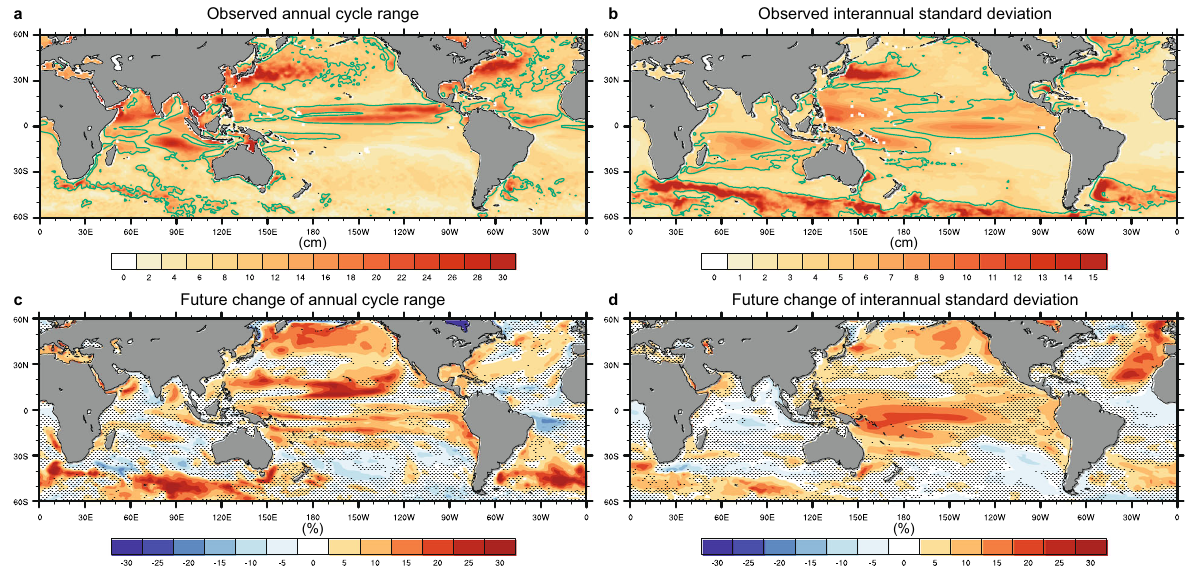
Fig. 1 Observed and projected changes in SSH variability. a , b The observed annual cycle range and interannual standard deviation (cm; shading), respectively from ORA-S5 (Methods). Contours enclose annual ranges and interannual standard deviations greater than 10 cm and 5 cm, respectively. c , d Multi-model mean (29 CMIP5 models) future projection for RCP8.5 with respect to the historical experiments for the annual cycle range and interannual standard deviation (% change). Stippling indicates grid points where less than 19 out of 29 models agree on the future change sign for annual cycle and interannual